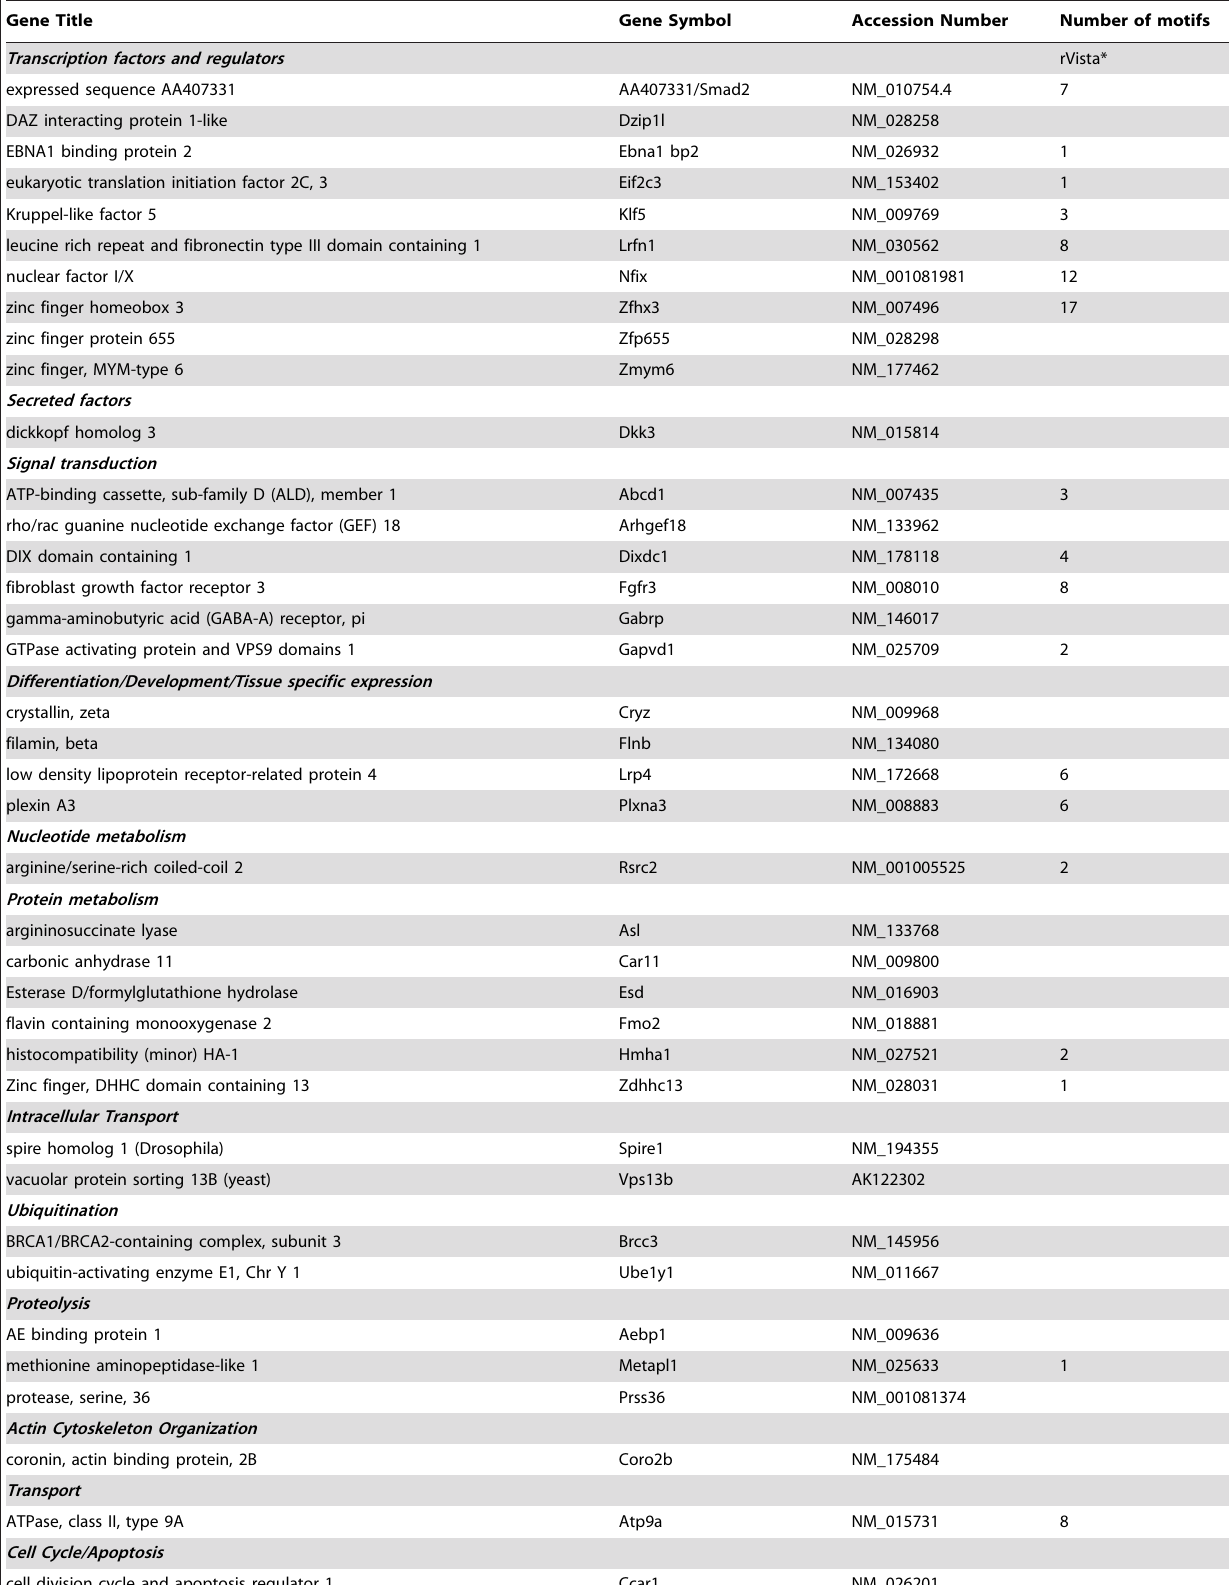
Table 1. Ap2 d and Ash2l Candidate Target Genes in Neuro2a